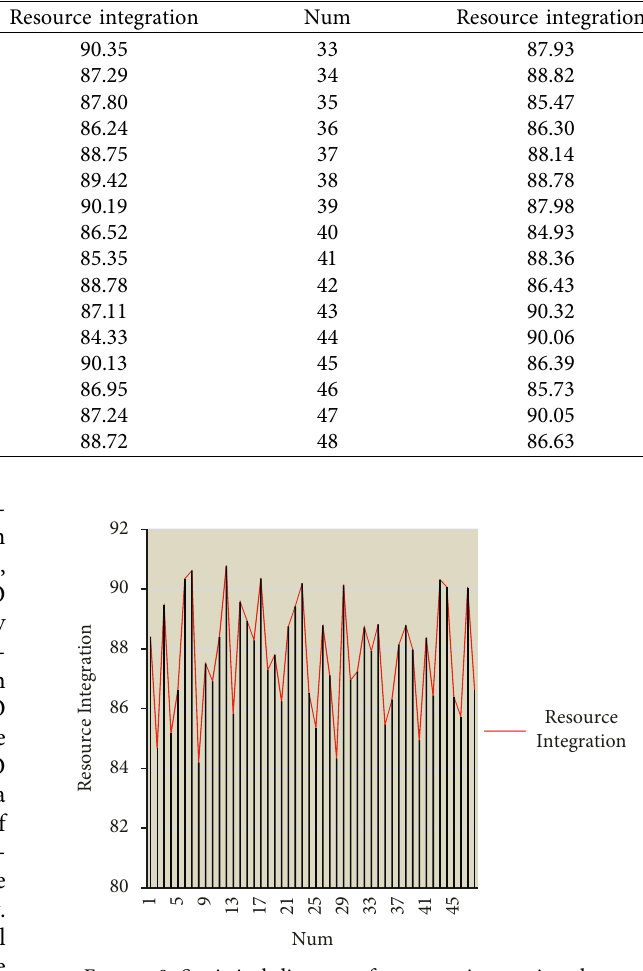
Figure 8: Statistical diagram of resource integration